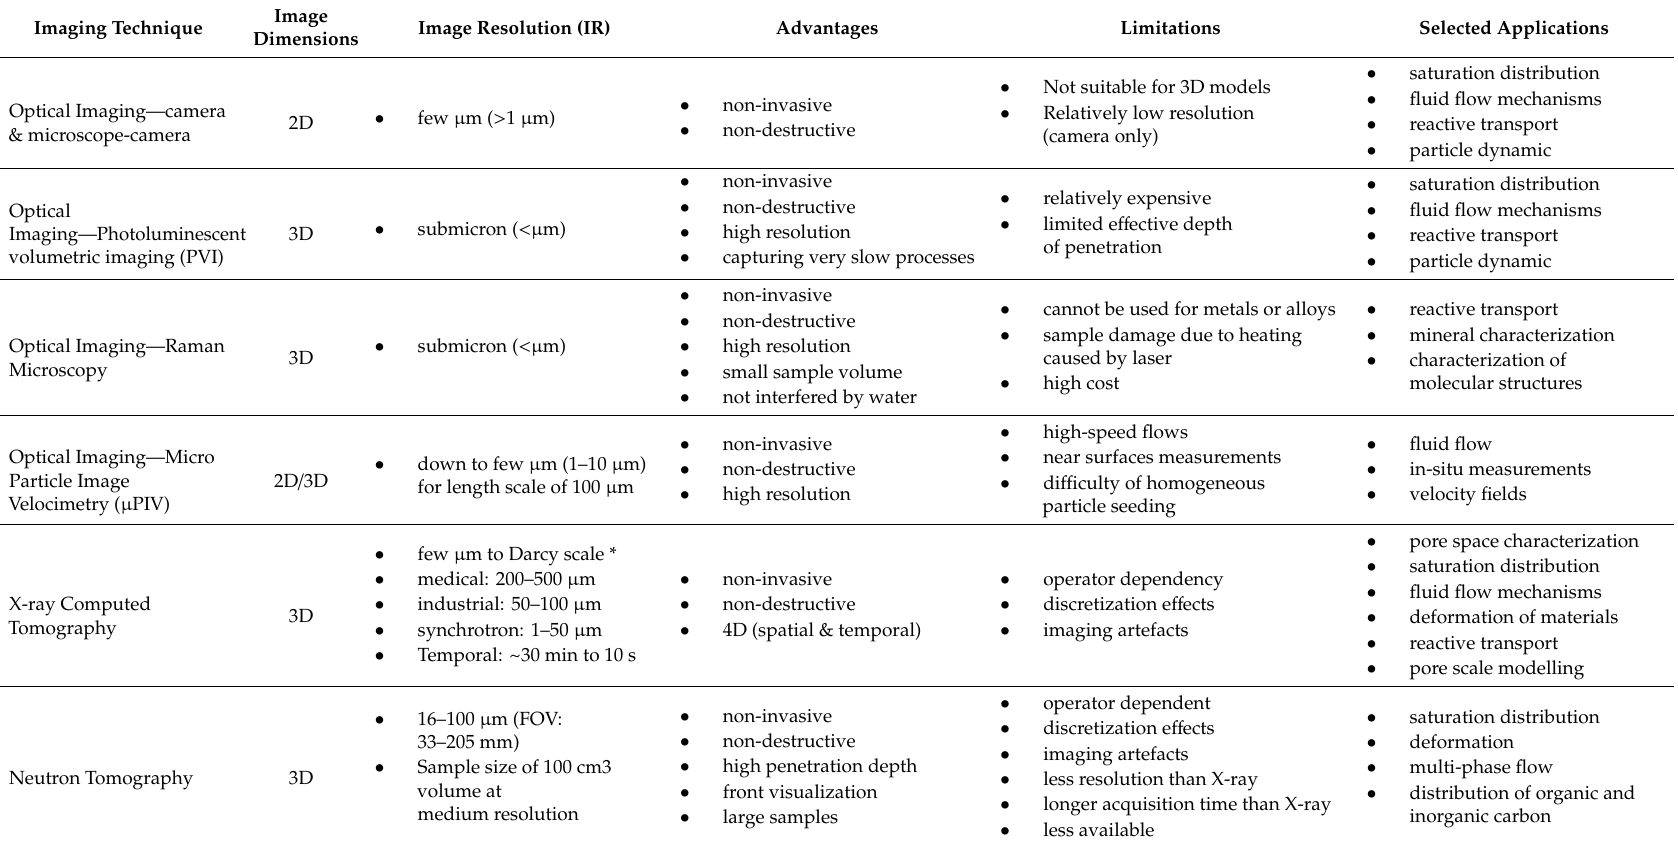
Table 2. Summary and comparison of imaging techniques reviewed in this